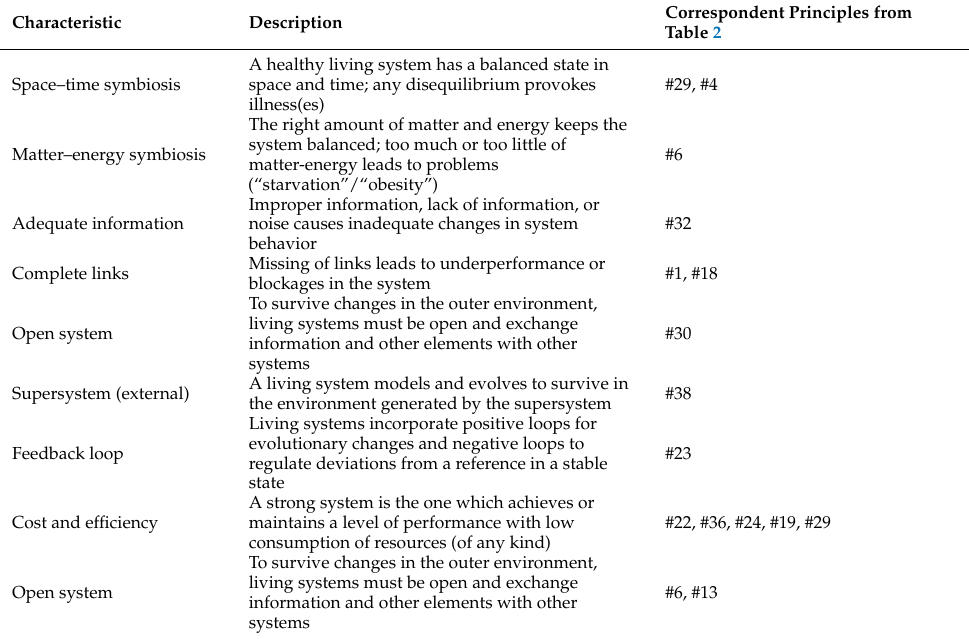
Table 4. Characteristics of a living